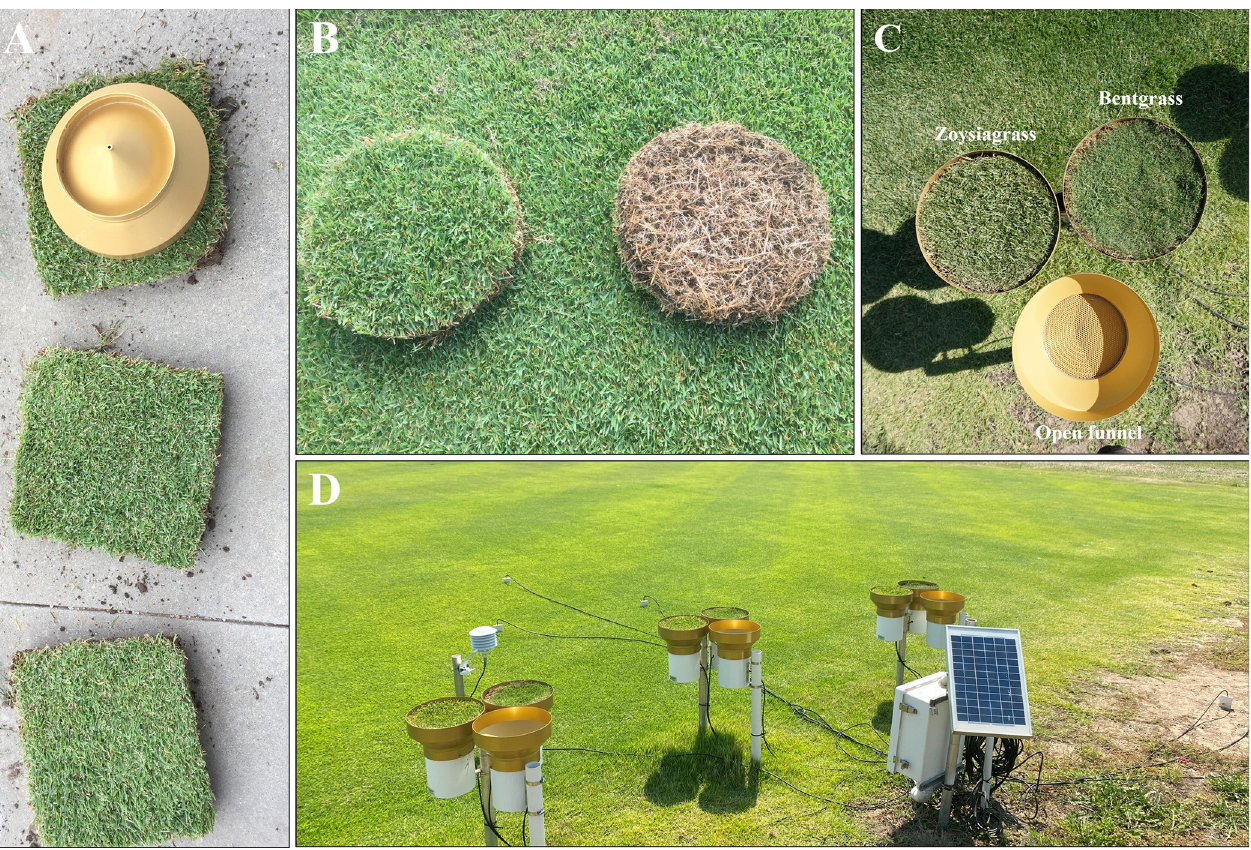
Fig 1. Figure illustrating A) the process of delineating and cutting the turfgrass patch using the pluviometer collector as template to ensure close fit, B) the top and bottom of a turfgrass patch after removing the soil attached to the bottom of the thatch layer and ready to be inserted into the pluviometer collector, C) a top view example of the pluviometers with and without the turfgrass patches of zoysiagrass and creeping bentgrass before the occurrence of a precipitation event, and D) the replicated field set up with showing three sets of three co-located pluviometers, a sensor for measuring air temperature and relative humidity, soil moisture sensors deployed in bare soil and below the surrounding zoysiagrass canopy, and associated logging